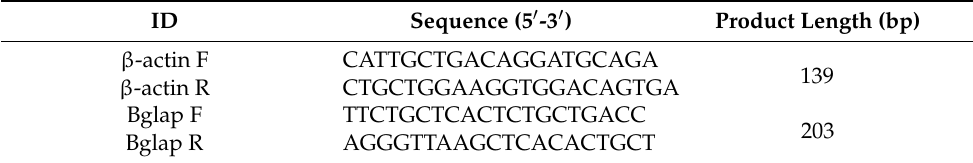
Table 1. Primer parameters of